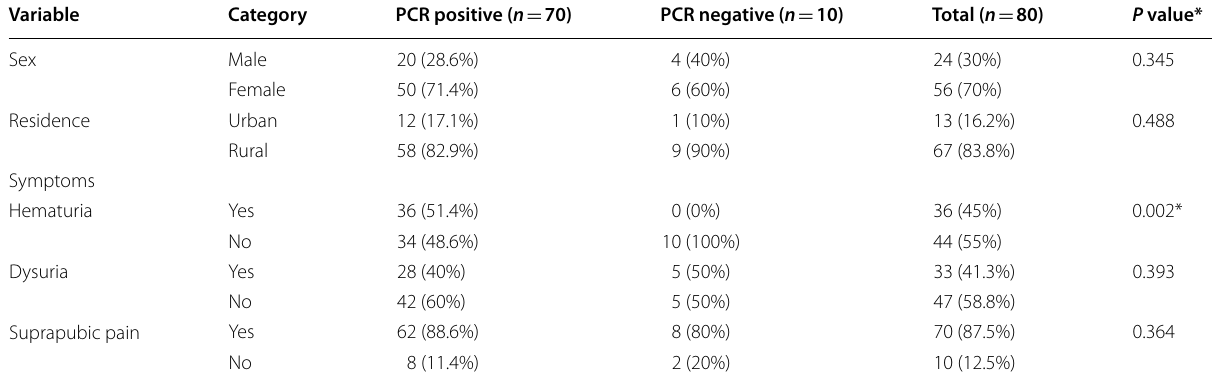
P value less than 0.5 is statistically significant